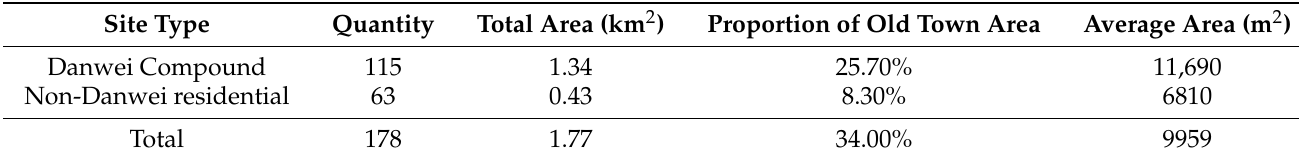
Table 1. Quantity and area of residential sites in Hefei Old Town area.